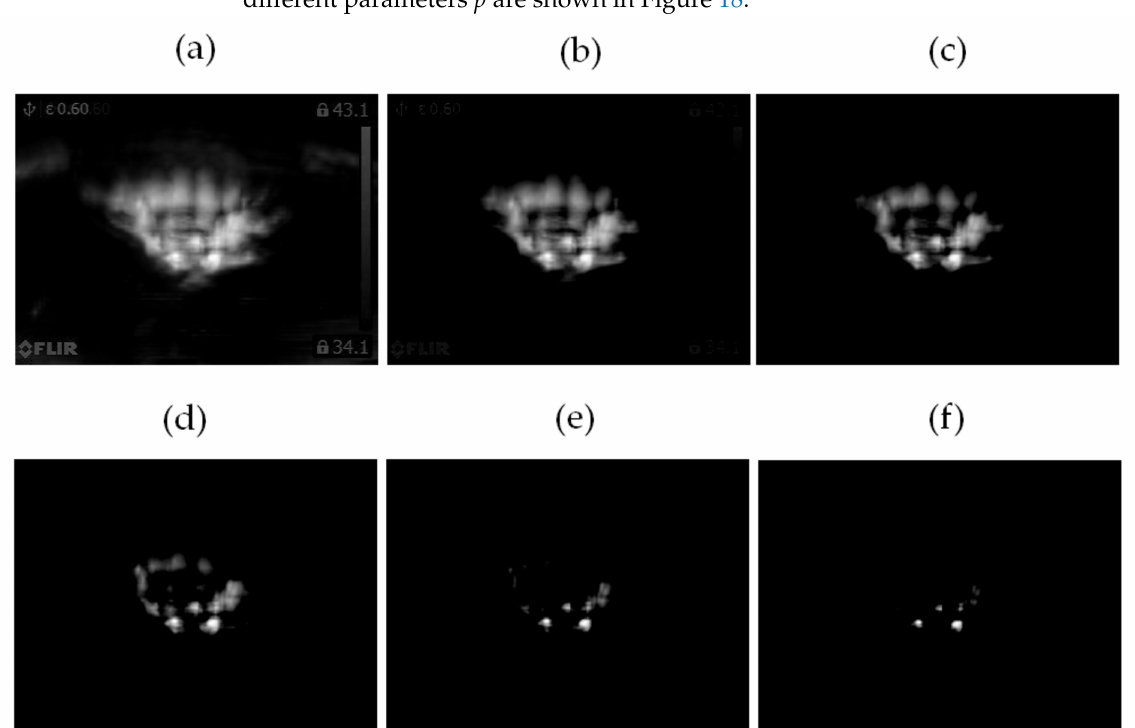
Figure 18. Thermal image of the healthy BLDC motor at 2100 rpm ( class 2 ) for the parameter ( a ) p = 0, ( b ) p = 0.3, ( c ) p = 0.5. Thermal image of the healthy BLDC motor at 2100 rpm ( class 2 ) for the parameter ( d ) p = 0.7, ( e ) p = 0.9, ( f ) p = 1.0. Thermal images of the healthy BLDC motor at 2100 rpm for parameter p = 0.3–0.5 are the best recognized by the human eye (Figure 18b,c). Step 9 performs image subtraction. This step is similar to the KNN classifier [23,24]. Forty-four training thermal images were used (for fans). For each test thermal image, there are 44 differences. Four differences (of 44 computed differences, parameter p = 0.5) are presented in Figure